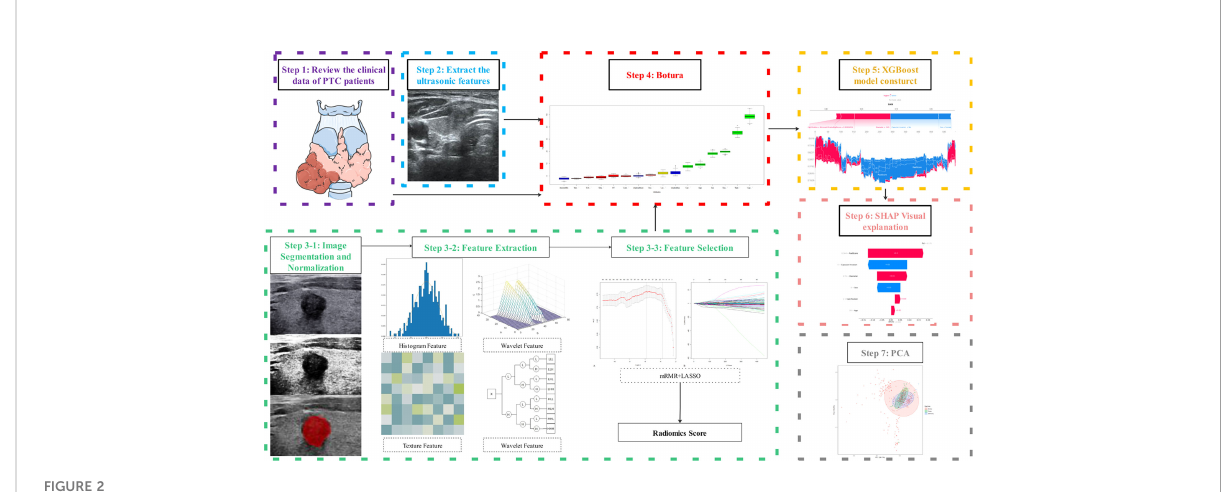
FIGURE 2 Flowchart of the